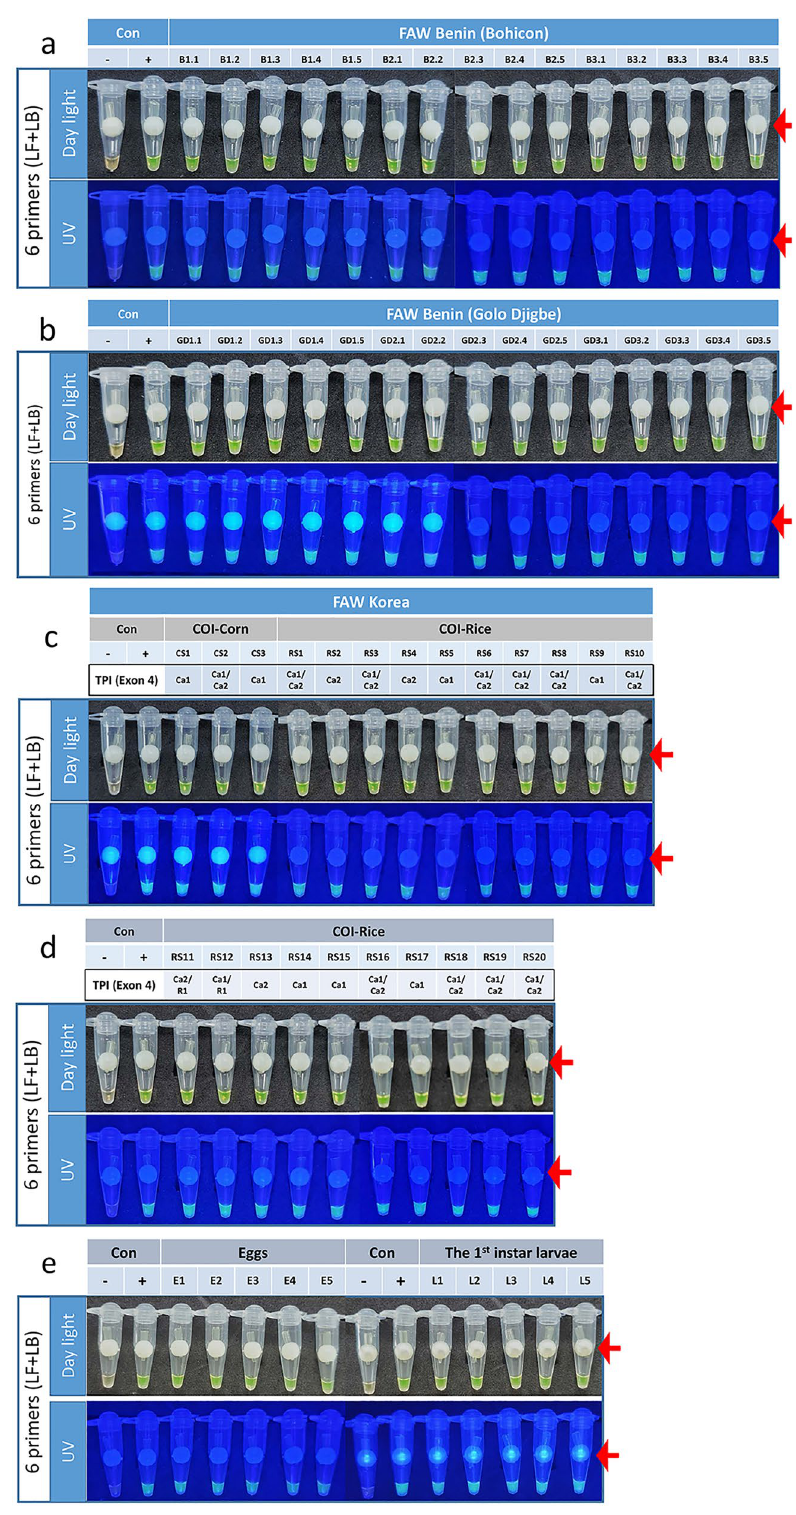
Figure 4. Sf6p-LAMP assays also recognized FAWs collected from Benin, Africa and eggs or 1st instar larvae of FAW within 30 min. ( a ) Sf6p-LAMP assays were performed on 15 FAW larvae collected from a corn field in Bohicon, Benin, Africa. ( b ) Fifteen FAW larvae collected in a corn field in Golo Djigbe were also tested with Sf6p-LAMP assays. ( c , d ) When 23 genomic DNAs from various genotype-based FAW strains were used for the Sf6p-LAMP assay, strong fluorescence signals were detected from all tested strains of FAW. ( e ) Eggs and 1st instar larvae of FAW were also detected by the Sf6p-LAMP assay. The red arrows indicate the contamination- free SYBR green delivery